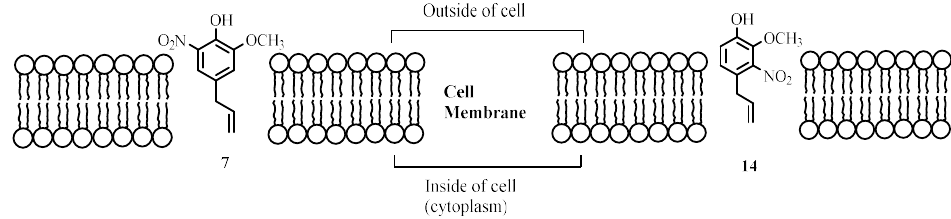
Figure 6. Schematic representation of nitro compounds 7 and 14 location in cell membrane.